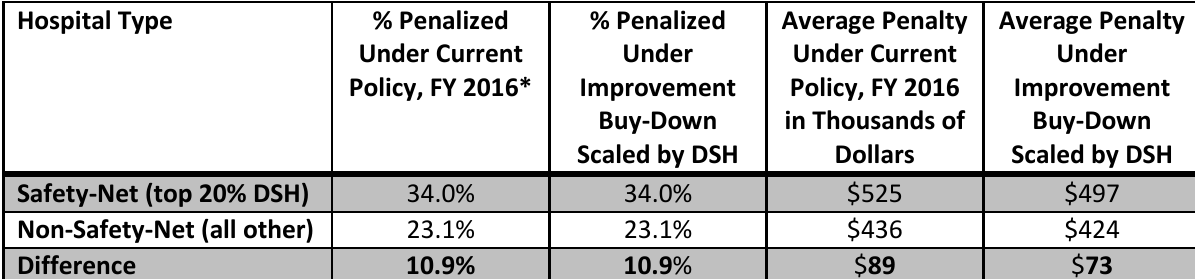
Table 6.19: Percent Penalized and Penalty Amount After Applying Improvement Buy-Down Scaled by